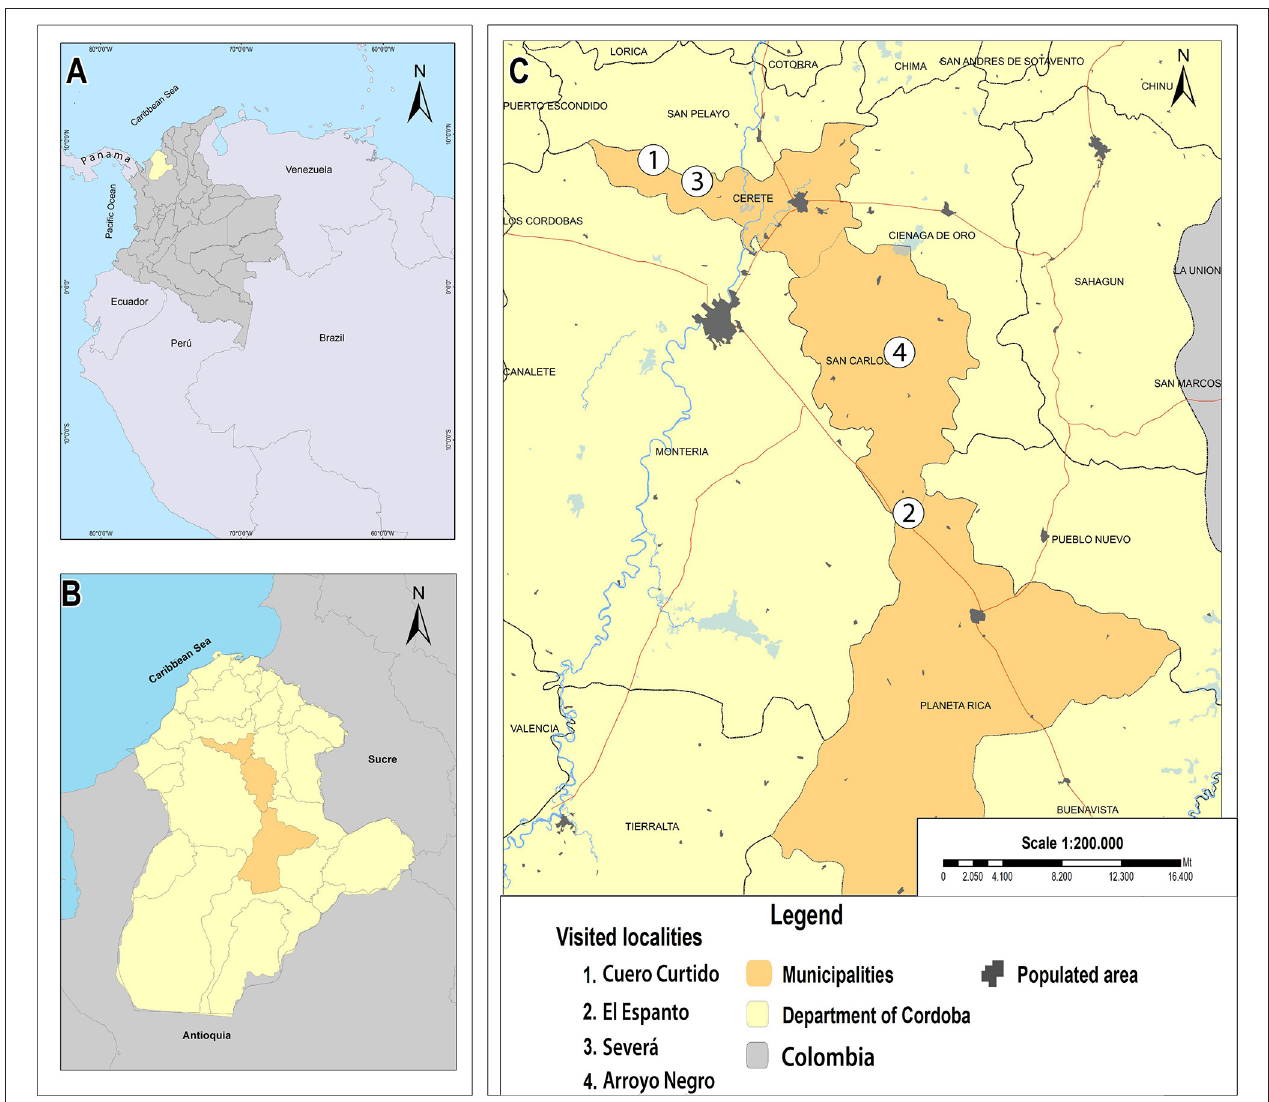
FIGURE 1 | Map showing the collection locations. (A) Map of South America showing the location of Córdoba department within Colombia. (B) Map of Córdoba department showing the investigated municipalities. (C) Studied localities within the Cereté, San Carlos, and Planeta Rica municipalities.